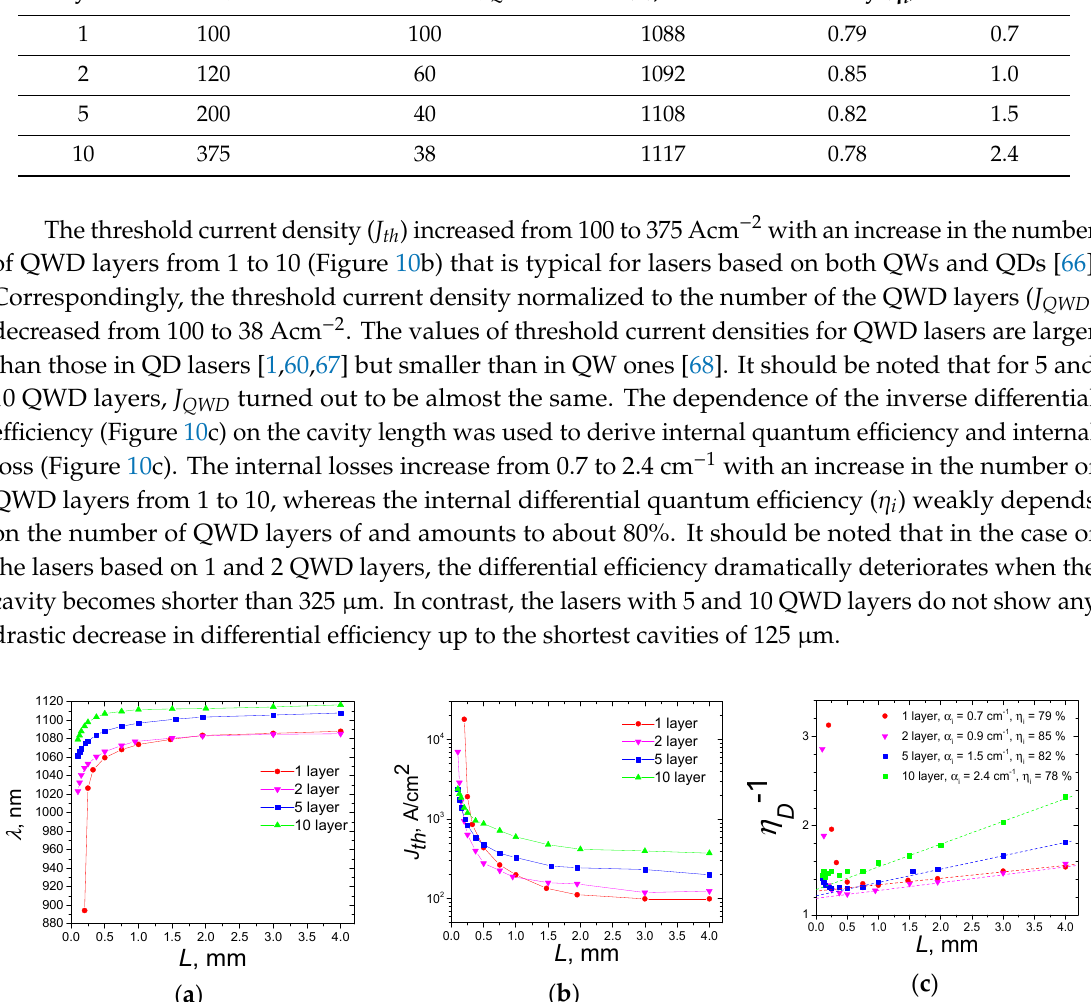
Table 2. The characteristics of edge-emitting lasers based on a di ff erent number of QWD layers. The threshold current density and lasing wavelength are indicated for the cavity length 4 mm.